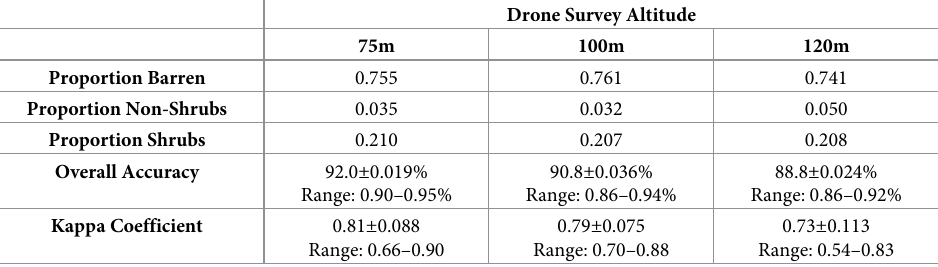
Table 1. Proportion land cover type classification of drone (Trimble UX5) imagery at three altitudes. Proportion values are obtained from the enumeration of pixel types for each land cover class across all 5 plots. Accuracy and kappa statistics presented as mean ± SD, along with the range of